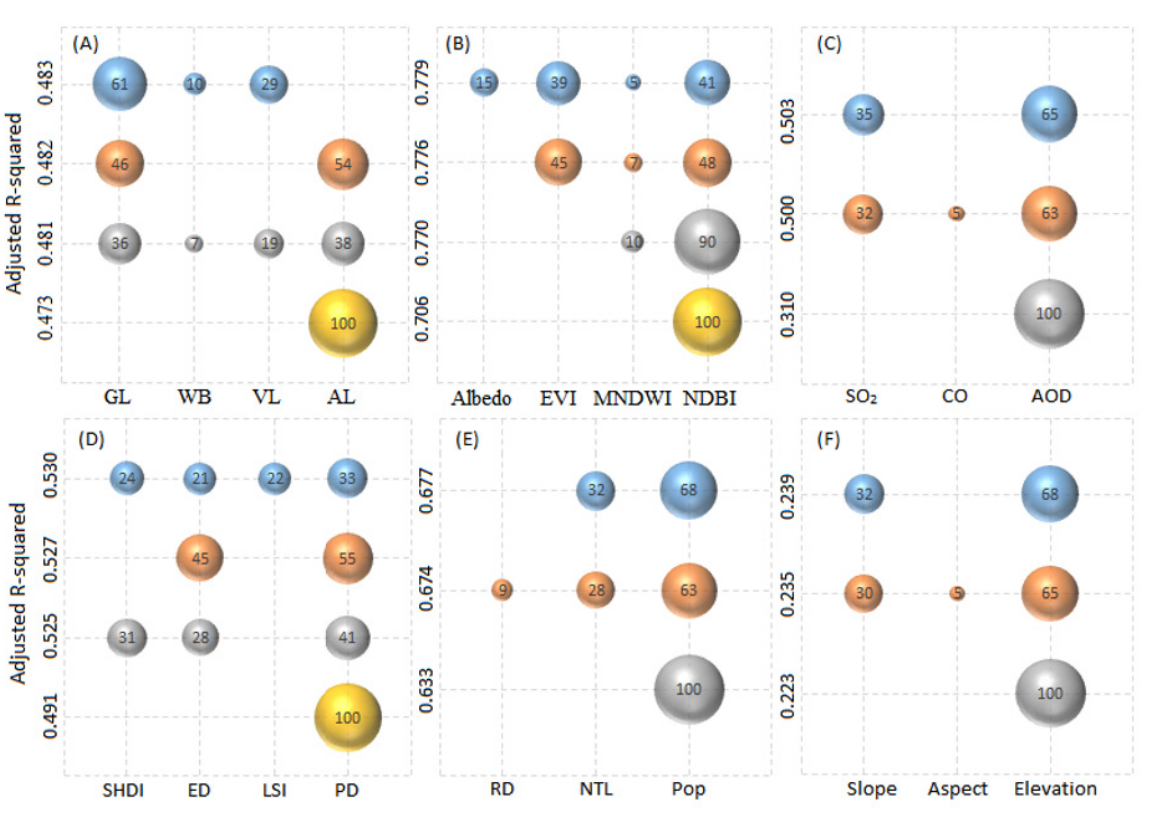
Figure 7. Results of all subset regressions of individual categories and independent effects of influencing factors. The bubble indicates that a variable entered into the each regression model. The size of the bubble represents the independent effects on LST in percentage. ( A ) Landscape compositions, ( B ) Surface properties, ( C ) Pollutant parameters, ( D ) Landscape configurations, ( E ) Socio-economic parameters, and ( F ) Topographical parameters.